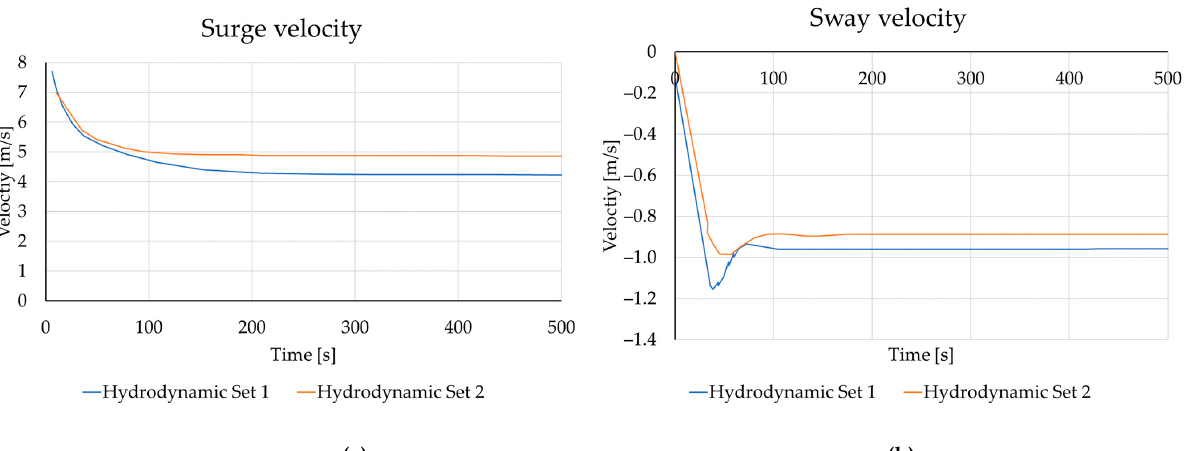
Figure 9. Turning circle test: ( a ) Surge force, ( b ) Sway Force, ( c ) Yaw moment.